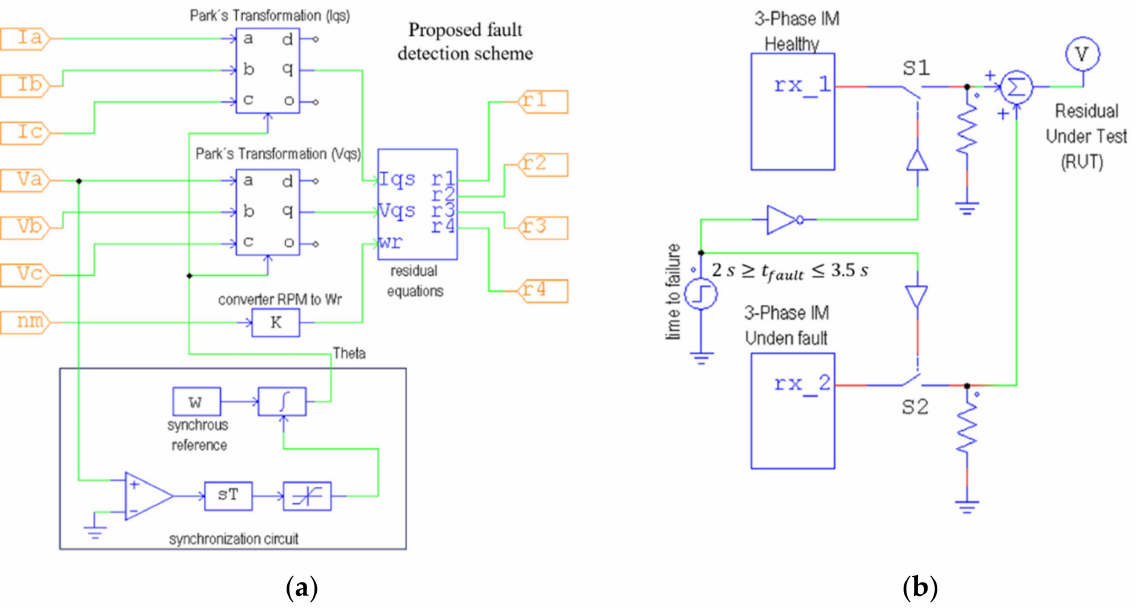
Figure 4. Detail of proposed fault detection scheme: ( a ) Proposed fault detection scheme; ( b ) residual under test with healthy and faulty